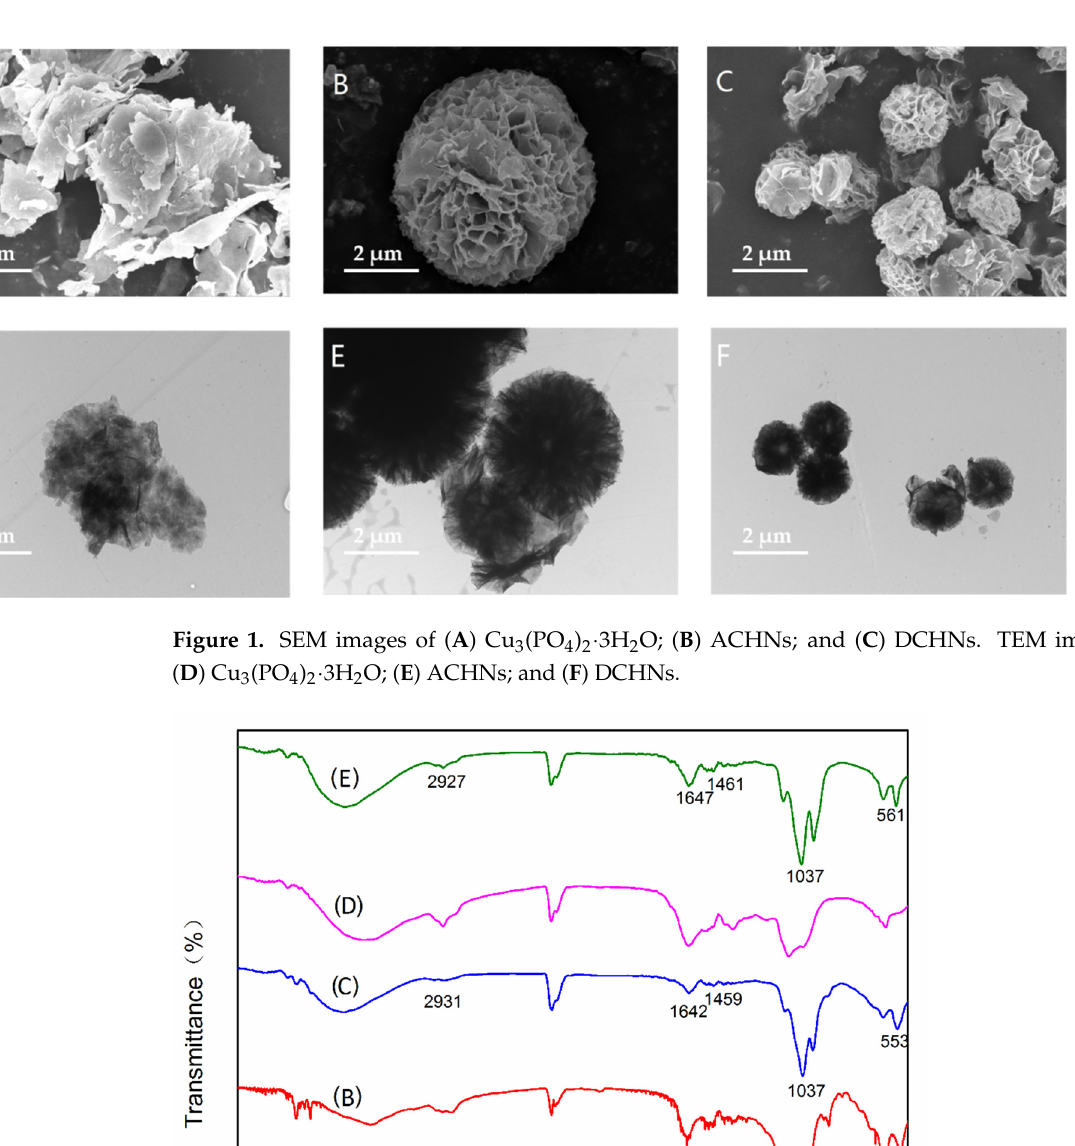
Figure 1. SEM images of ( A ) Cu 3 (PO 4 ) 2 ·3H 2 O; ( B ) ACHNs; and ( C ) DCHNs. TEM images of ( D ) Cu 3 (PO 4 ) 2 ·3H 2 O; ( E ) ACHNs; and ( F ) DCHNs.